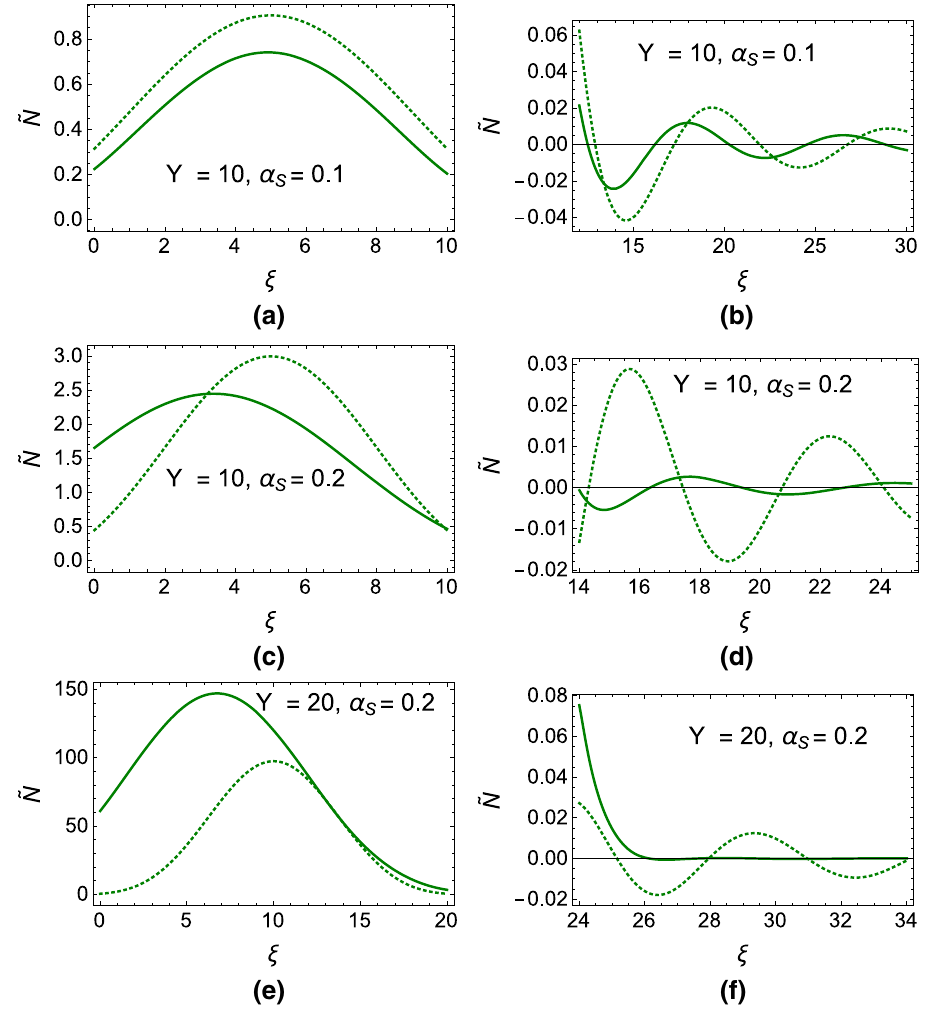
Fig. 7 Solutions of Eq. (49) (solid lines) and solution of Eq. (43) (dotted lines) in different kinematic